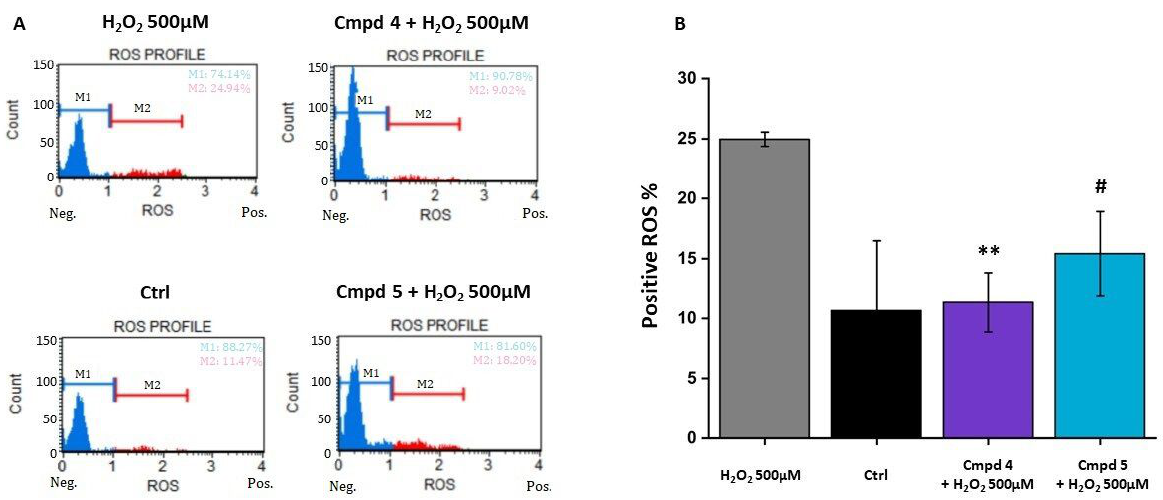
Figure 5. Treatment with 4 or 5 reduces the production of reactive oxygen species (ROS). Cells were pre-treated for 24 h with compounds 4 or 5 at the chosen concentration of 100 µ M and then ex- posed for 3 h with H 2 O 2 500 µ M. ( A ) Representative histograms of ROS-negative (M1, blue) and ROS- positive (M2, red) cells; ( B ) The bar graph shows the percentage of ROS-positive cells. (Ctrl: control group, no compounds or H 2 O 2 exposure). Values in the graph indicate % of ROS+ cells as the mean ± SE obtained from n = 3 of independent experiments; statistics: one-way ANOVA test followed by Levene’s post-test; ** p ≤ 0.01 ( 4 : 100 µ M vs. H 2 O 2 500 µ M; # p ≤ 0.05 ( 5 : 100 µ M vs. H 2 O 2 500 µ M).